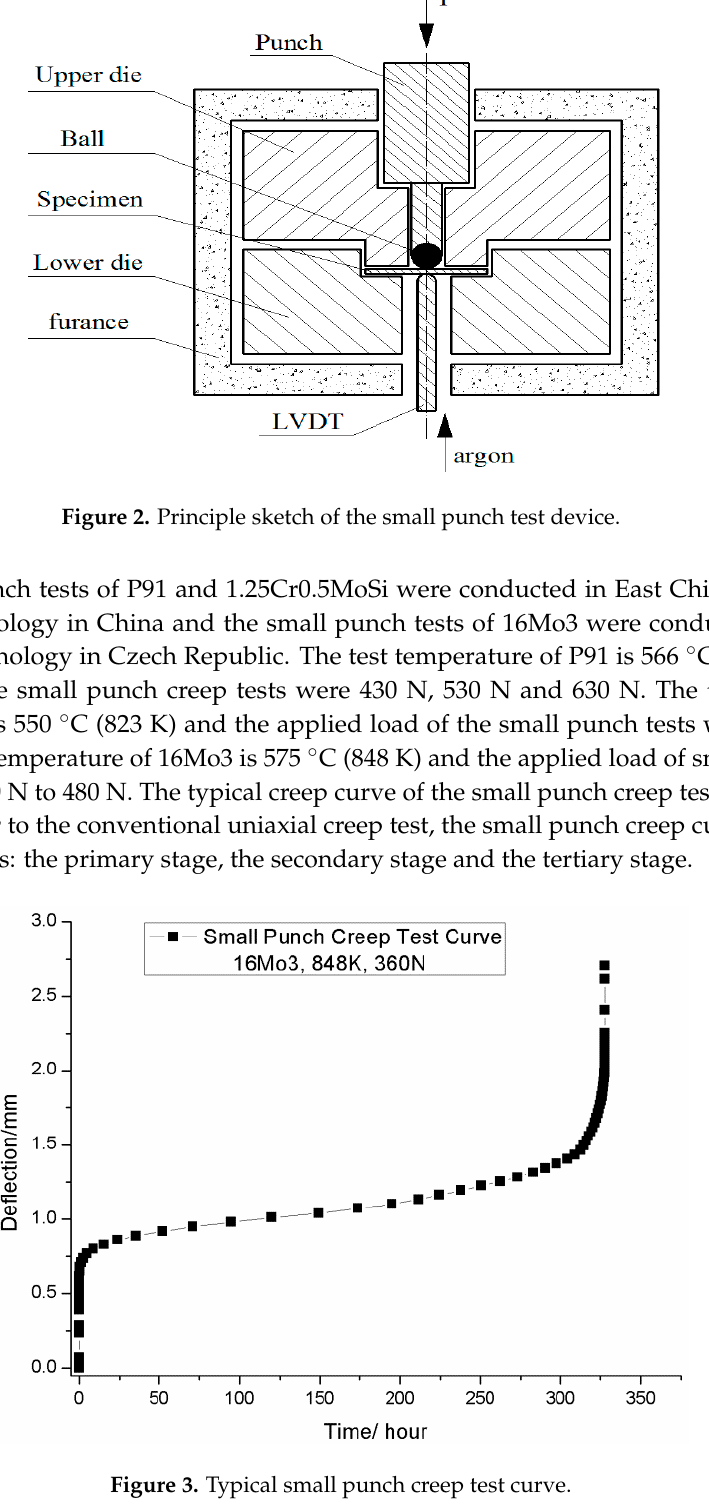
Figure 3. Typical small punch creep test curve.